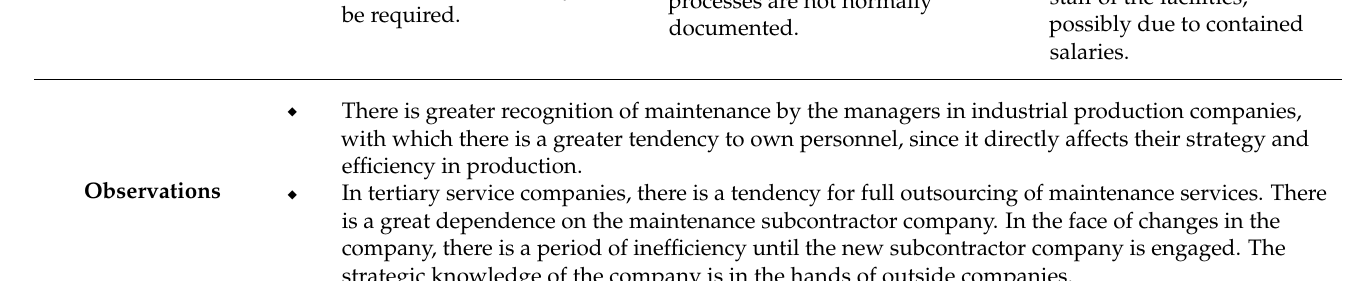
Table 2. Characteristics observed in the case study in reference to